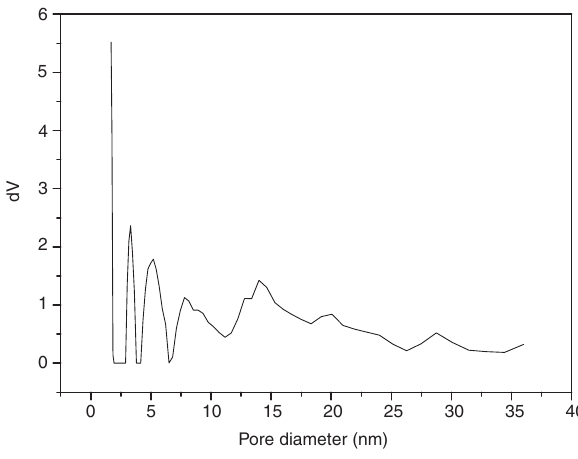
Figure 5: Dependence of derivative volume dV on pore size,